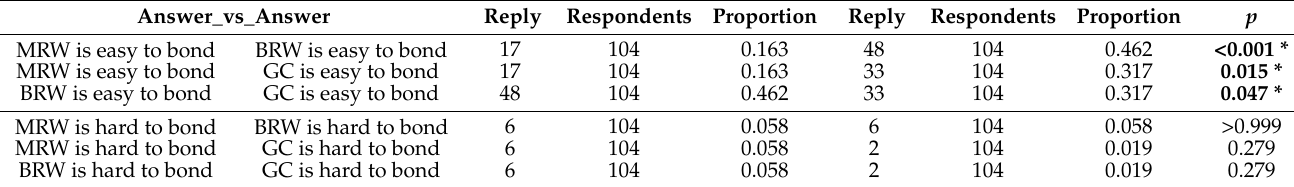
Table 3. Distribution of opinions on wire bonding.